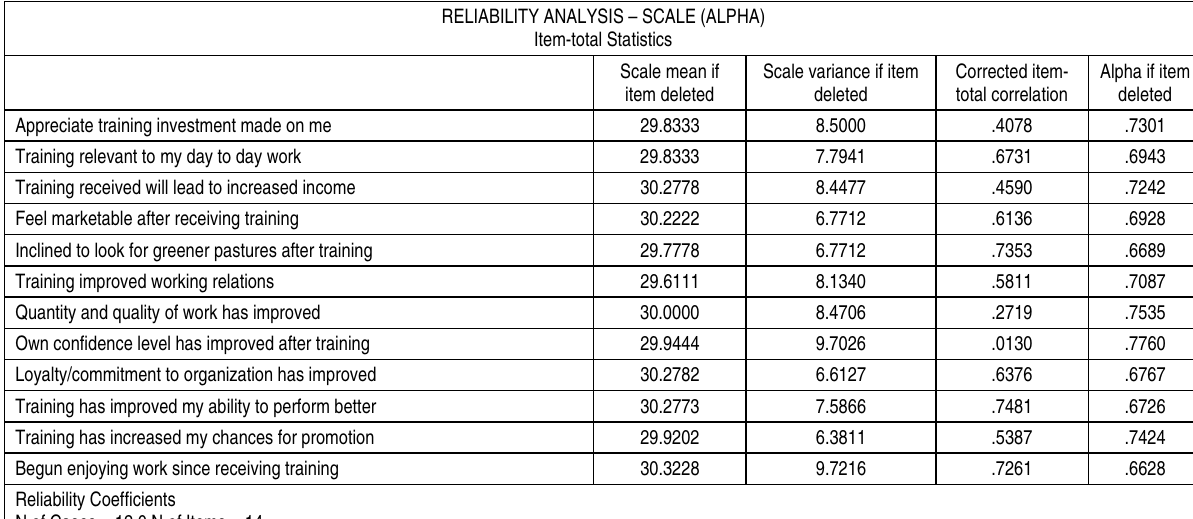
Table 2 (cont). Reliability analysis of “organizational commitment” measuring instrument RELIABILITY ANALYSIS – SCALE (ALPHA) Item-total Statistics